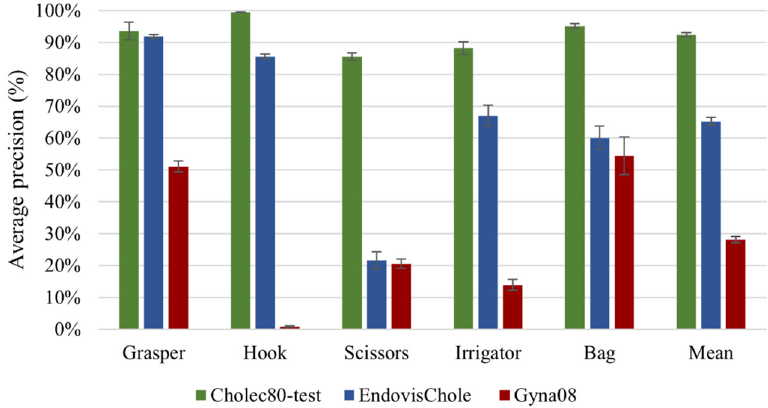
Figure 7. Results of generalisation to other surgical locations and types of procedures.